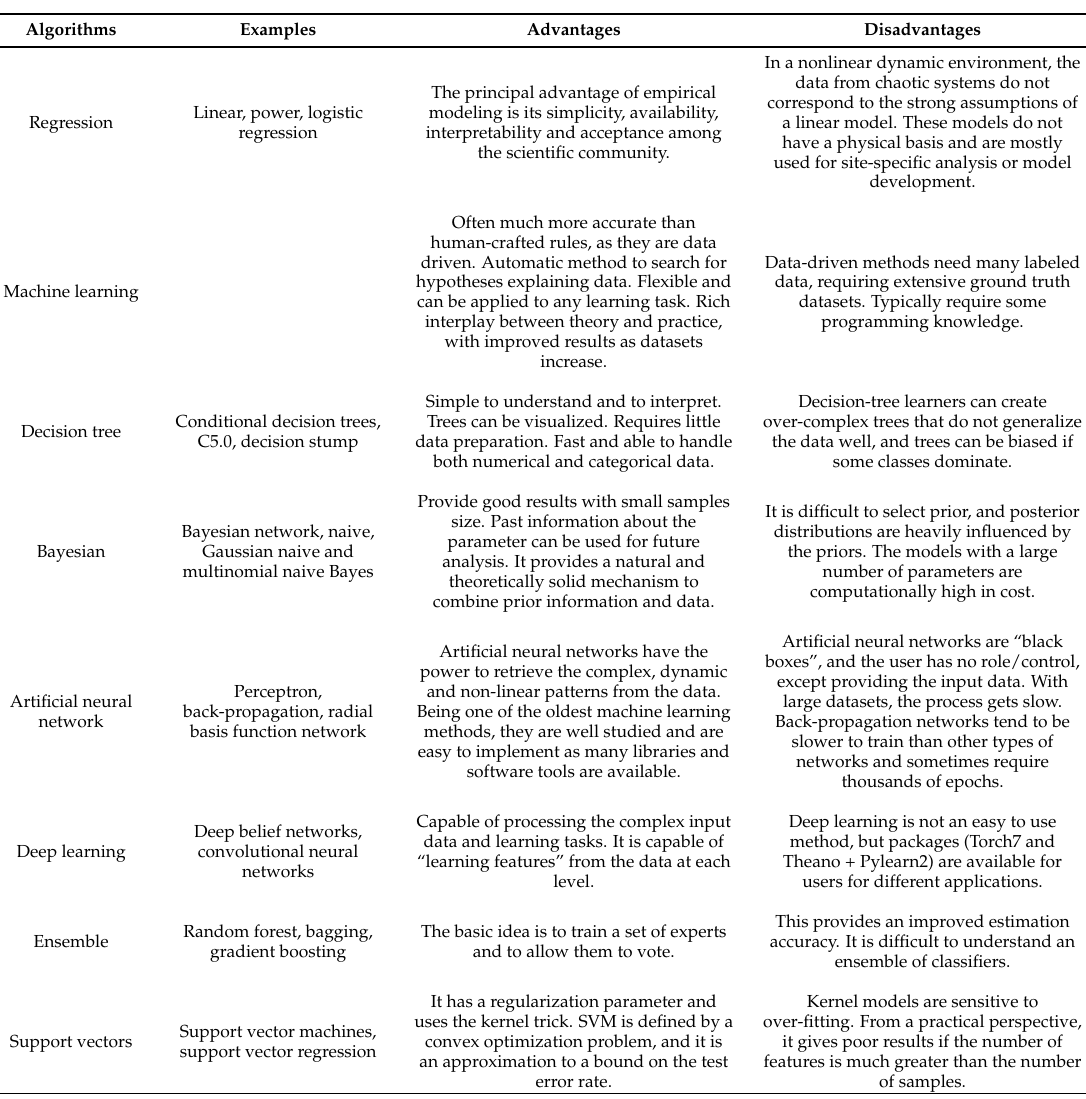
Table 6. List of most commonly-used regression/empirical models and the state-of-the-art machine learning